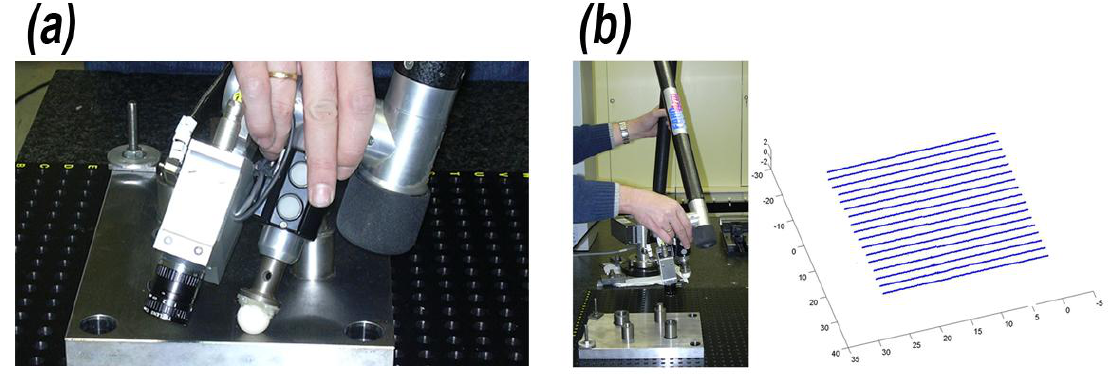
Figure 10. Gauge plane: (a) Contact measurement for nominal data on AACMM global frame. (b)